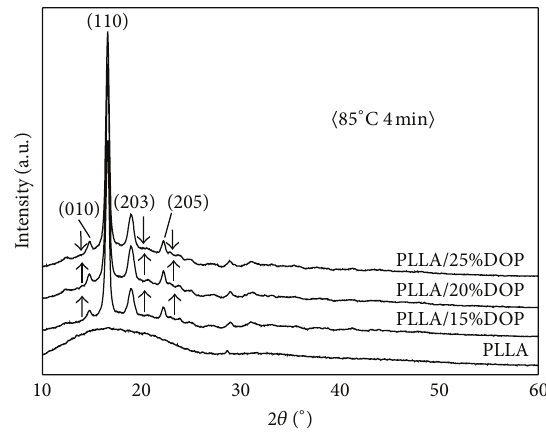
Figure 2: XRD curves of PLLA and PLLA/DOP samples.